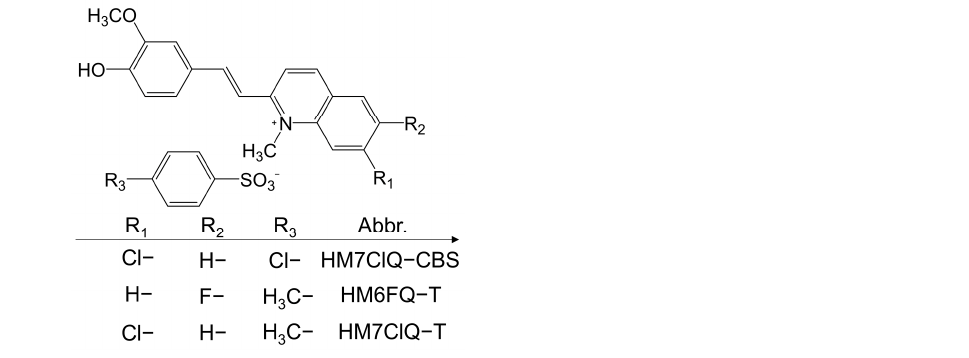
Figure 5. Chemical structures of quinolinium-based HM7ClQ-CBS, HM6FQ-T, and HM7ClQ-T.